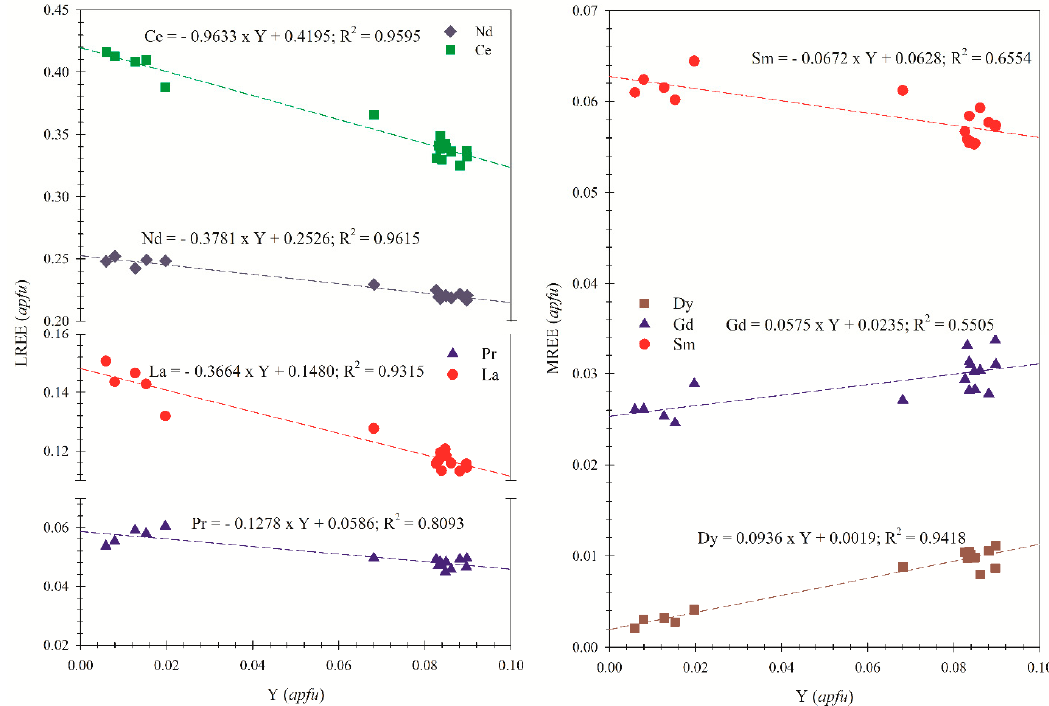
Figure 9. Variations of LREE (left set) and MREE (right set) with Y in sample 2a. The dashed lines are linear fits and their equations are given as inserts.